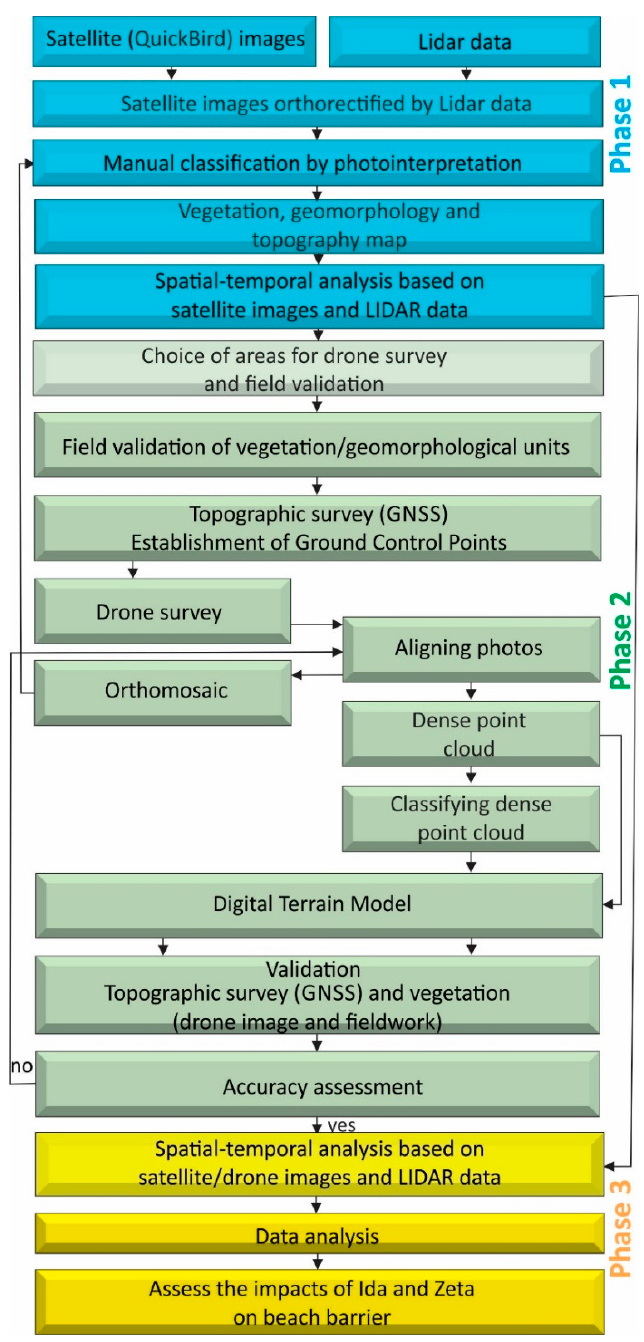
Figure 3. Methodological flow-chart of the spatial-temporal analysis.